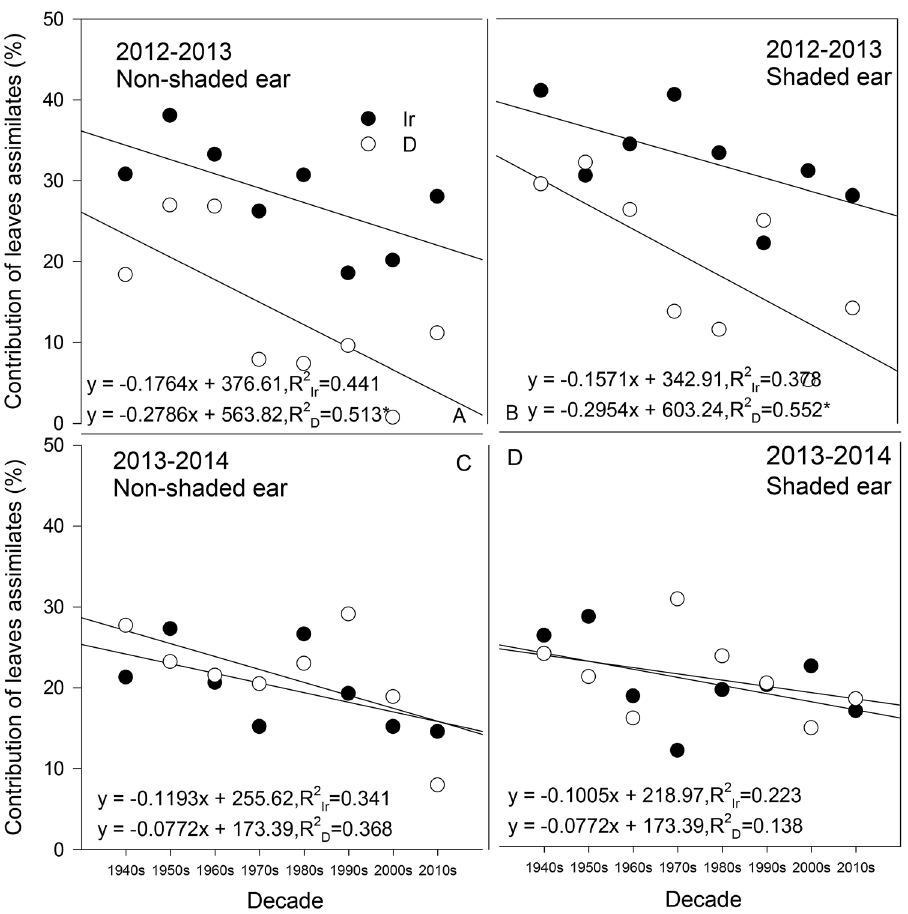
Figure 6. Postanthesis contribution of leaf assimilates (CLA) to grain weight in different cultivars. **Significant at P < 0.01; Ir indicates the irrigation treatment; D indicates the drought